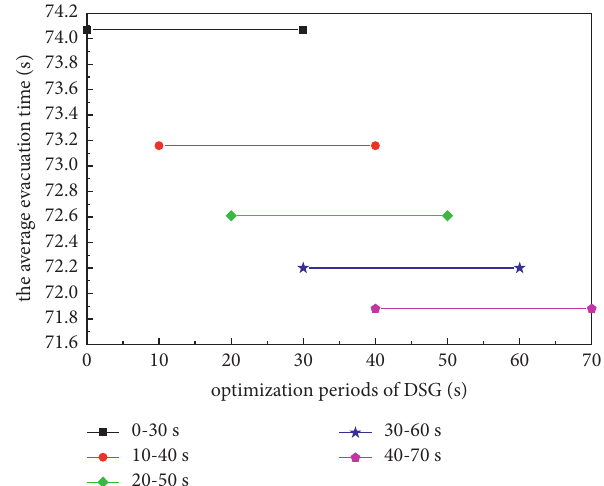
Figure 8: The average evacuation time with different number of sign direction optimization.